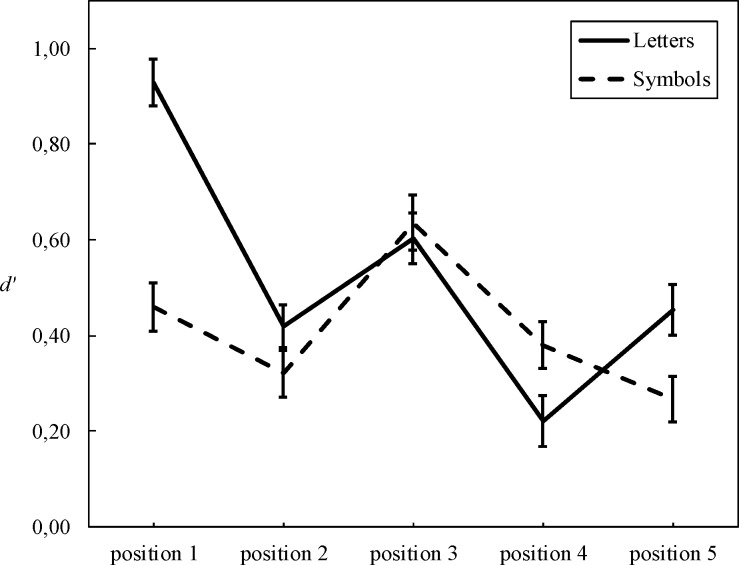
d’ as a function of position for the letter and symbol tasks.Bars represent standard errors.